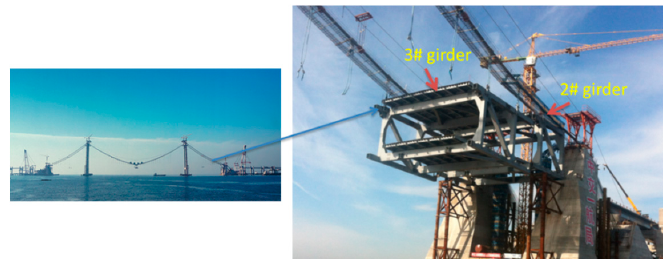
Figure 13. Location of the second girder.